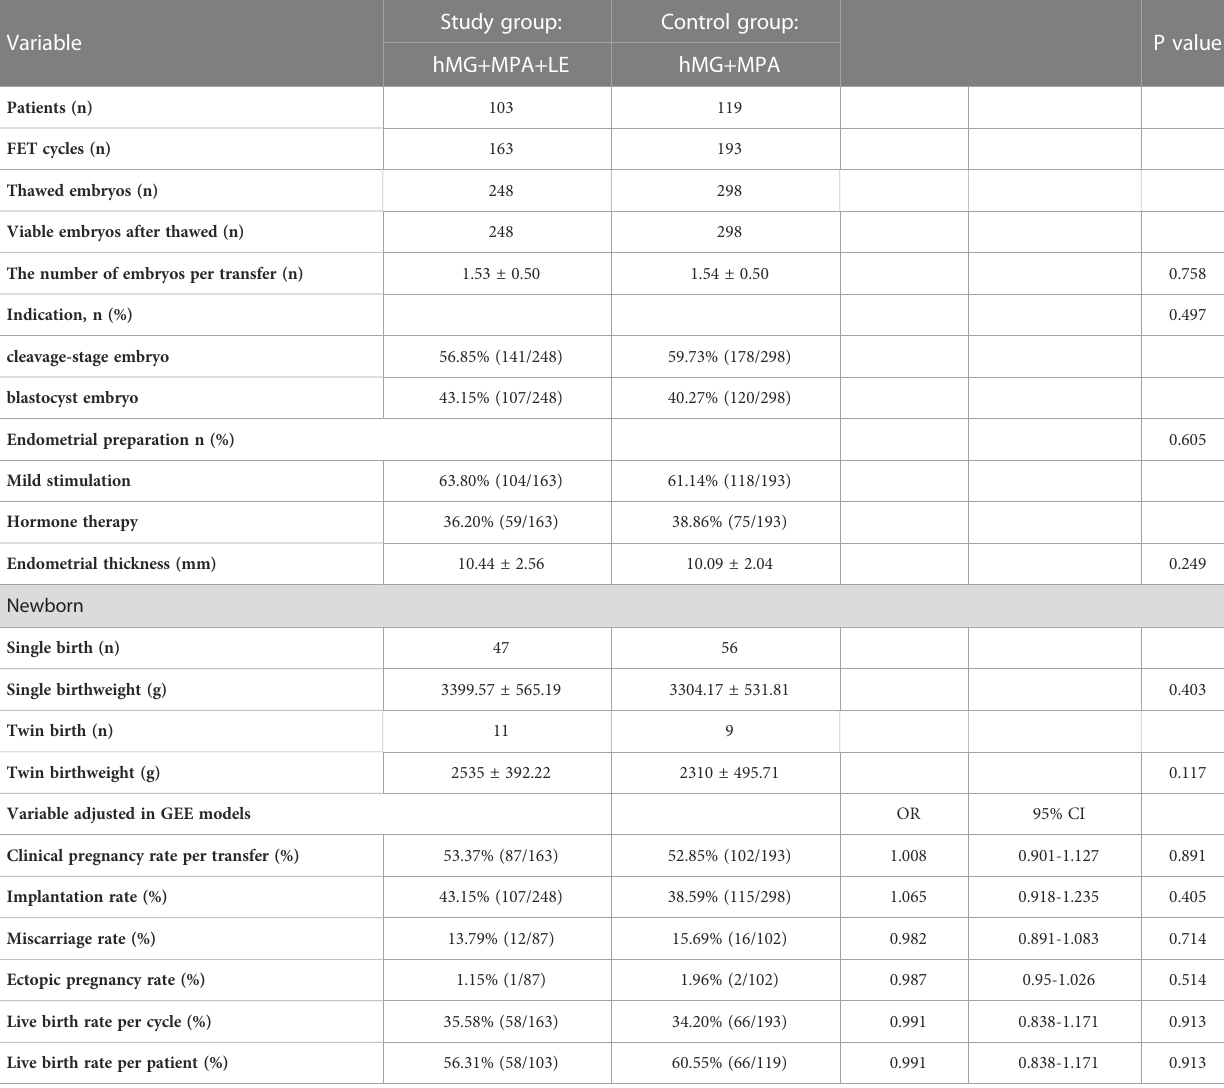
TABLE 3 Pregnancy outcomes after